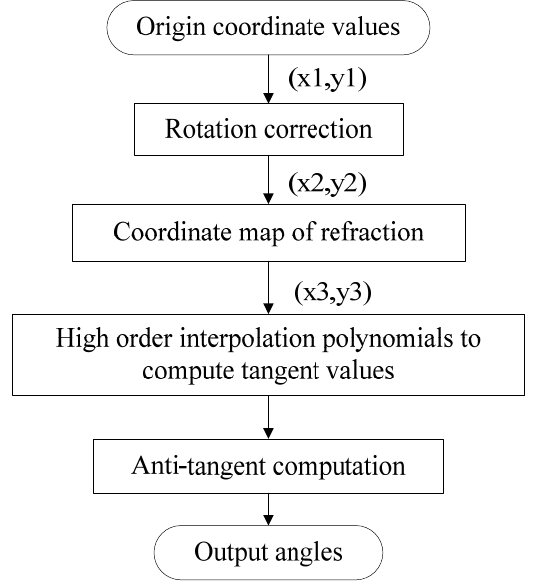
Figure 5. The flow chart of error compensation of DSS.